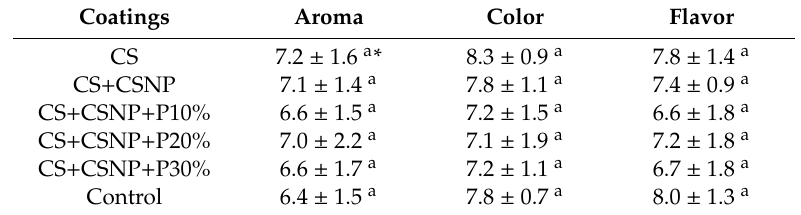
Table 7. Sensory characteristics of strawberry fruit treated with di ff erent nanostructured